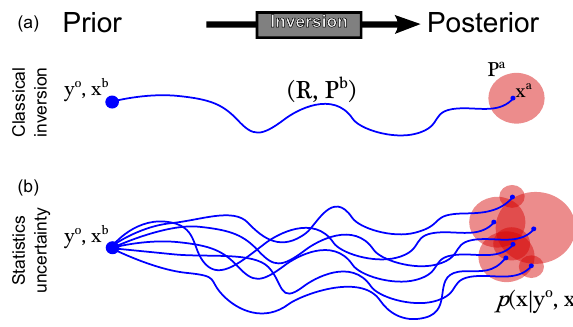
Figure 1. Statistic uncertainty in Bayesian inversion. The inver- sion infers the posterior state x a from y o and x b . In the classical Bayesian framework, x a is inferred together with its uncertainty P a from the covariance matrices ( R , P b ) (a) . To account for uncertain- ties in the error statistics, an ensemble of ( R , P b ) couples can be tested to infer an ensemble of ( x a , P a ) (b) , which are part of p( x | y o , x b )